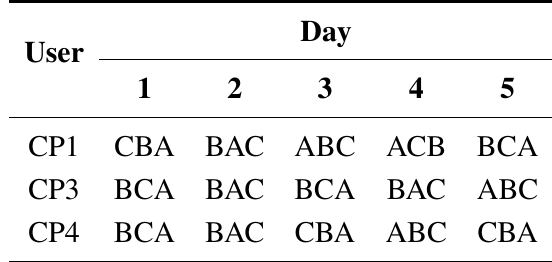
Table 6. Randomized design of the experiments. ( A ) Without filter; ( B ) With RKF; ( C ) With incremental method.